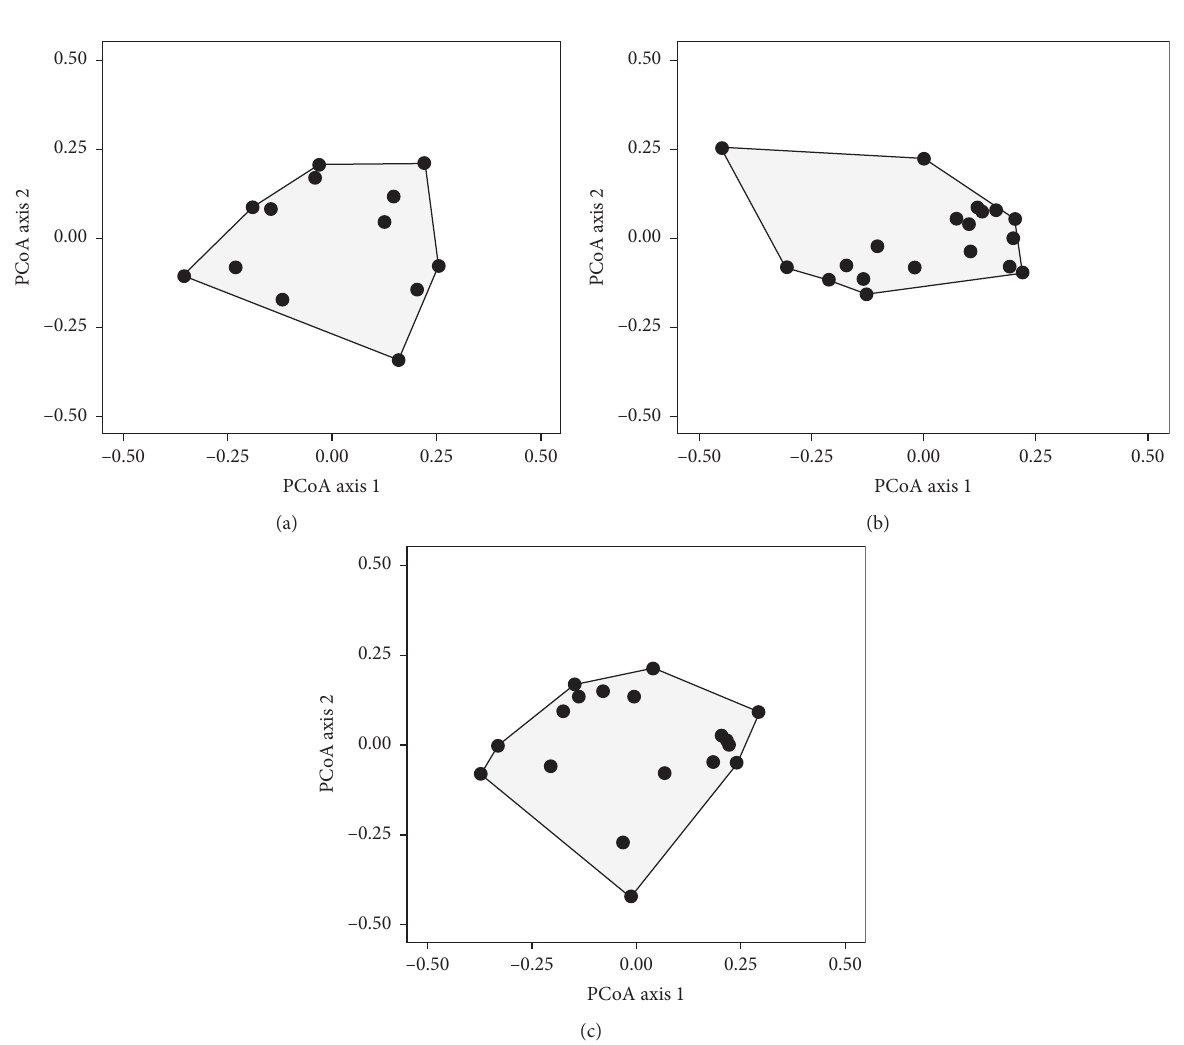
Figure 3: Functional richness of savanna tree community represented as the minimum convex hull enclosing all species in a community (denoted here by the area of the grey polygon), in (a) high fire frequency (HFF), (b) medium fire frequency (MFF), and (c) low fire frequency (LFF)